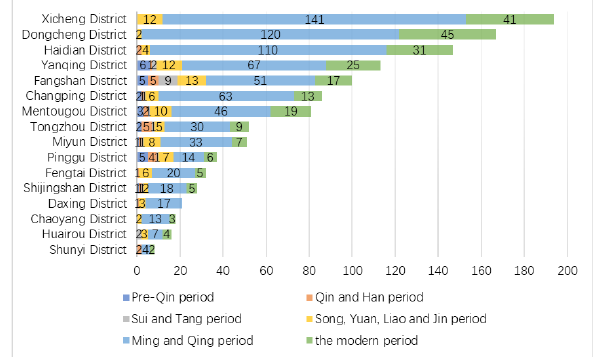
Figure 4. Bar Chart of Historical Stages of Cultural Preservation Units in